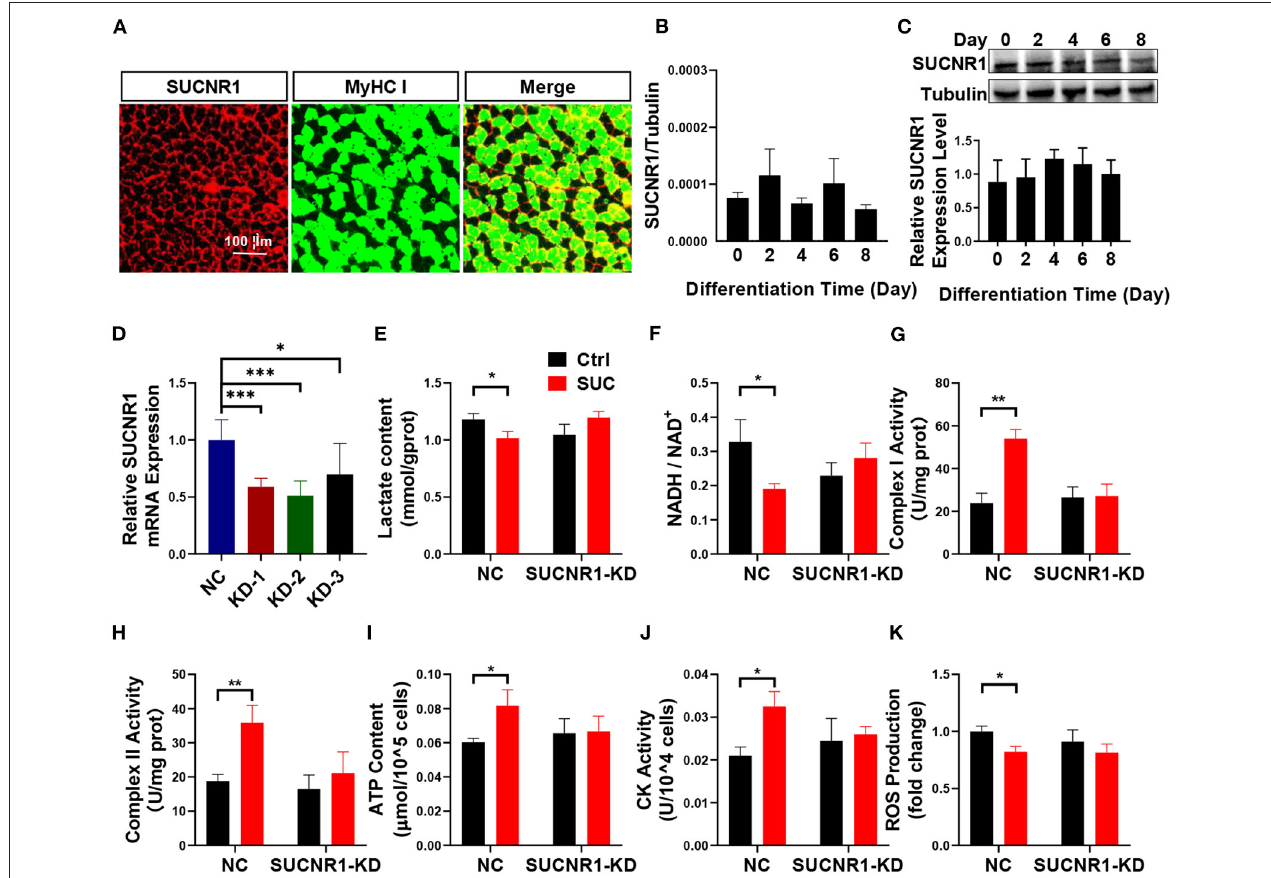
FIGURE 3 | SUCNR1 is required for the short-term effects of SUC in C2C12 cells. (A) Immunofluorescence staining; red for SUCNR1 and green for MyHC I. (B) Absolute quantitative detection of SUCNR1 mRNA expression level compared to tubulin. (C) WB to detect the SUCNR1 protein expression level in a different induced day. (D) SUCNR1 relative mRNA expression level after being treated with three different SUCNR1 siRNAs for 24h. The cells in (E–K) SUCNR1 knockdown by SUCNR1 siRNA and were then induced to differentiate for 4–6 days; 1mM SUC cells were treated for 1h to detect related factors. (E) Lactate content.